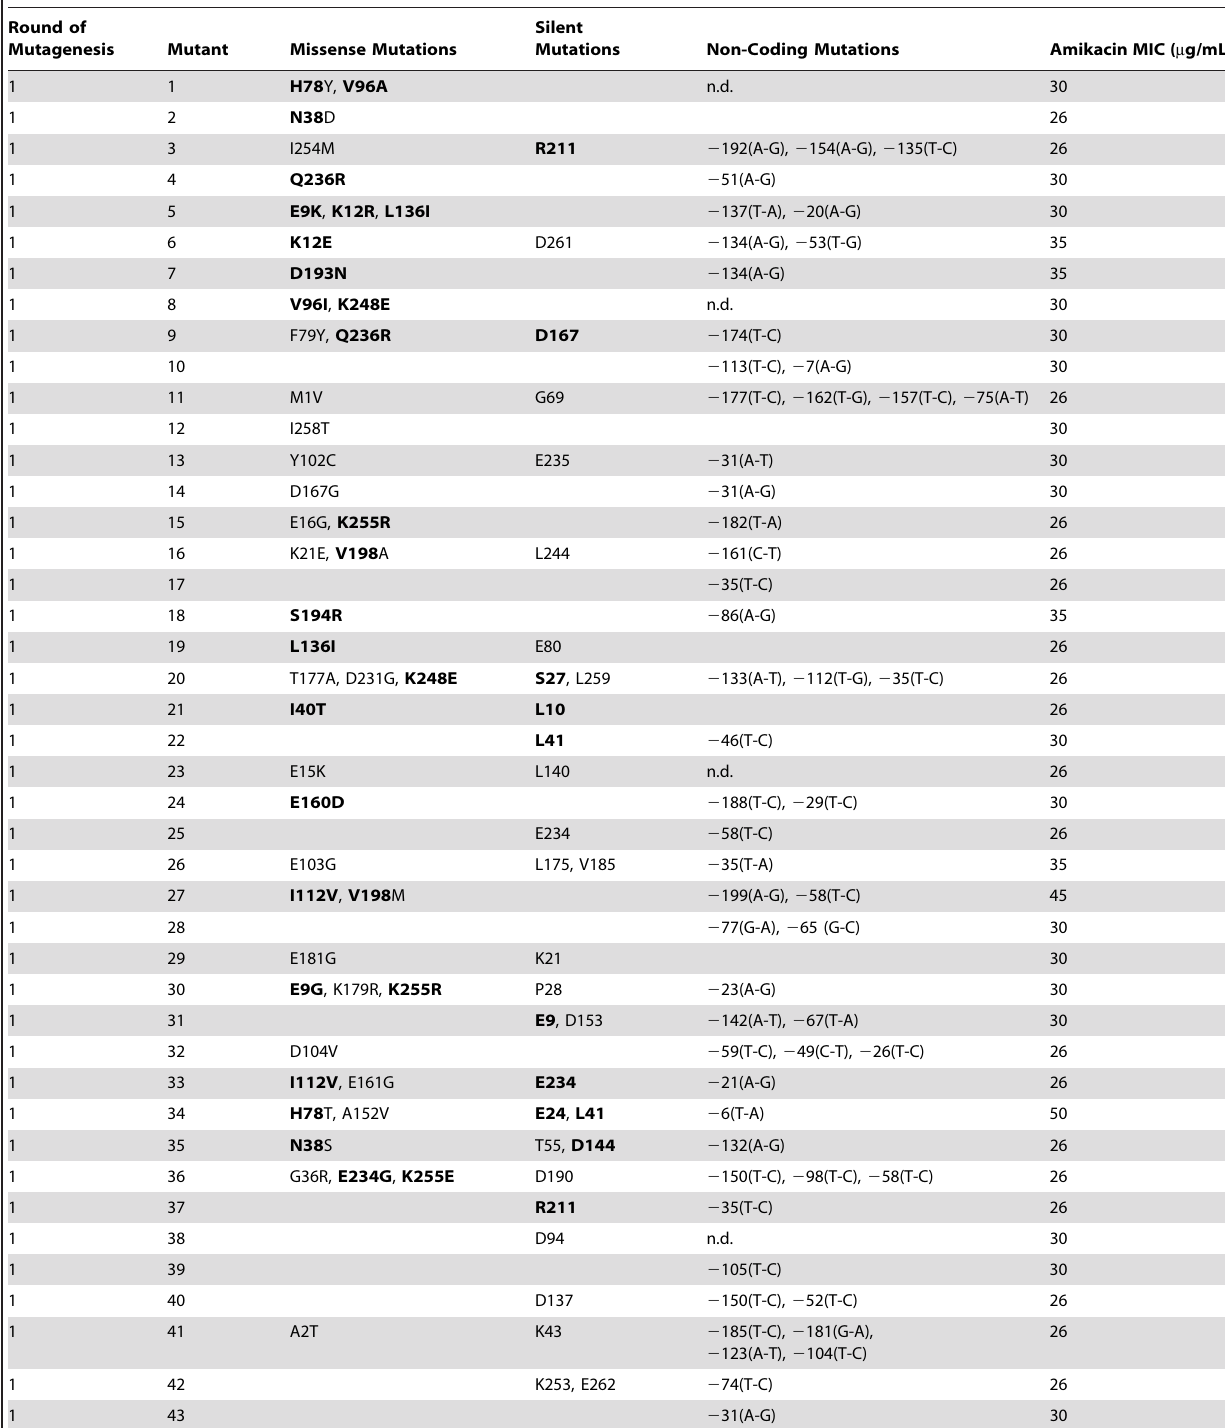
Recurring mutations are written in bold text.